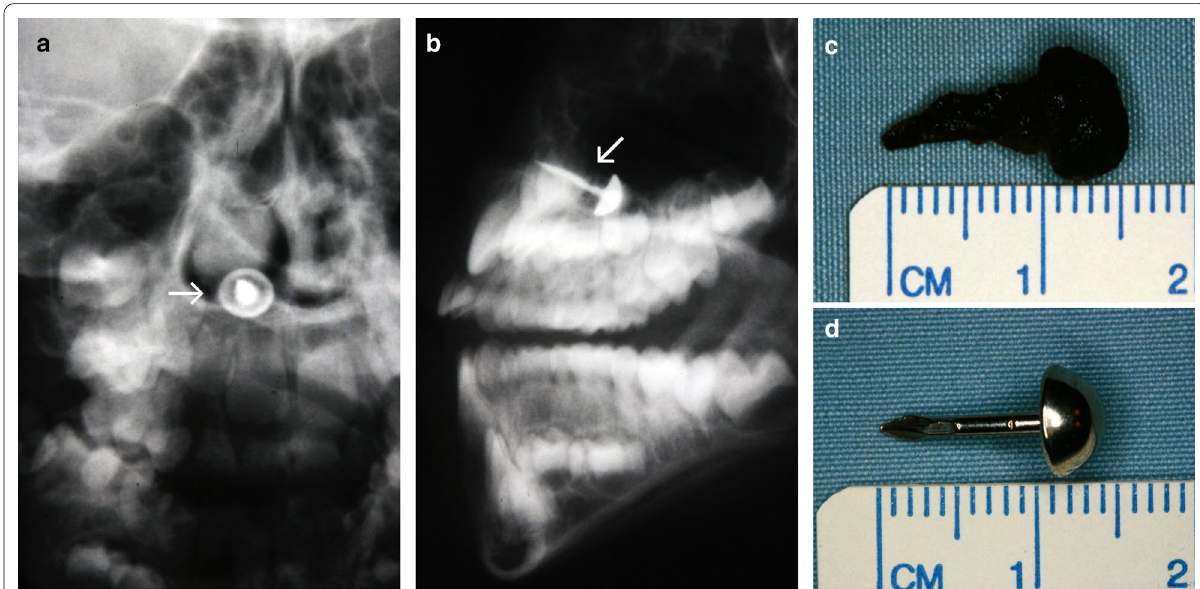
Fig. 5 Carpet nail. Anteroposterior ( a ) and lateral ( b ) radiographs displaying a radiopaque object (arrow) in projection over the lower right nasal meatus. Photographs of a dislocated carpet nail after removal from the lower meatus ( c , d ). Adherent blood clots can impair the clinical detection of foreign